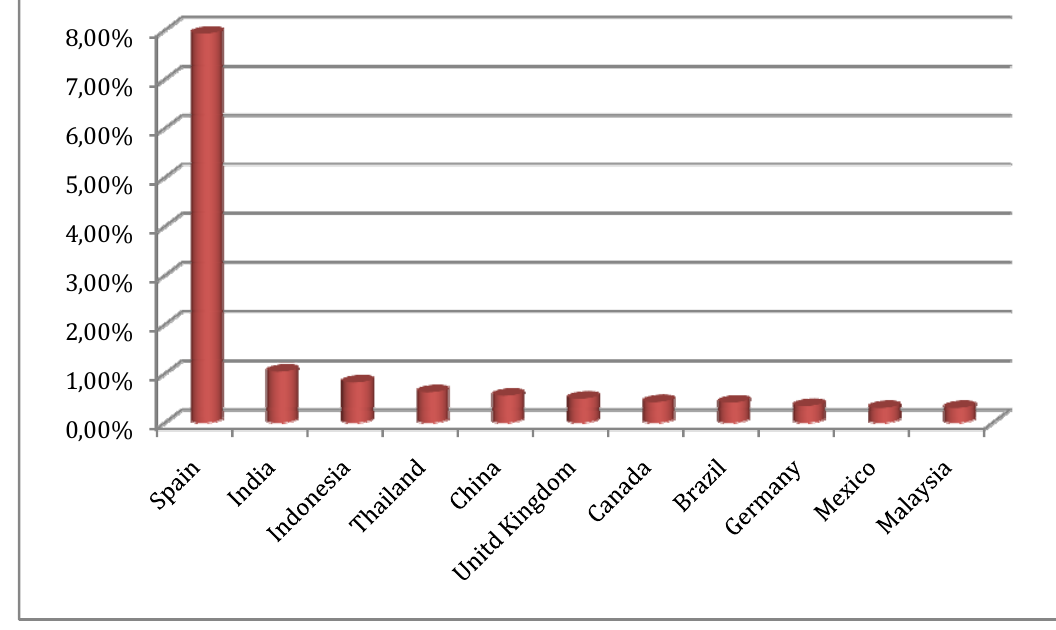
Figure 4. “Main countries of access to the journal in